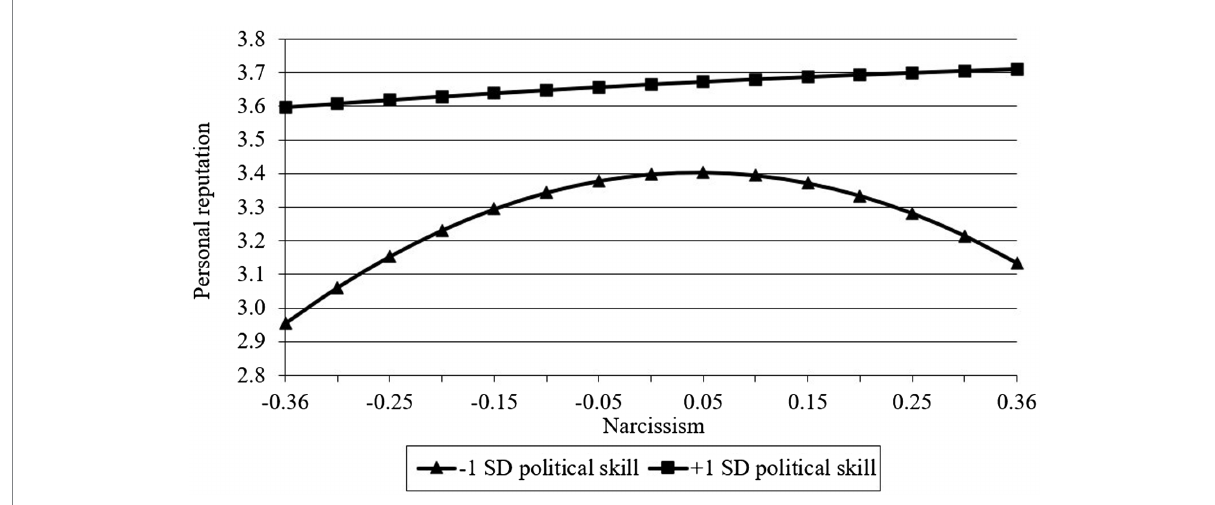
FIGURE 3 The moderating effect of political skill on the relationship between narcissism and personal reputation.